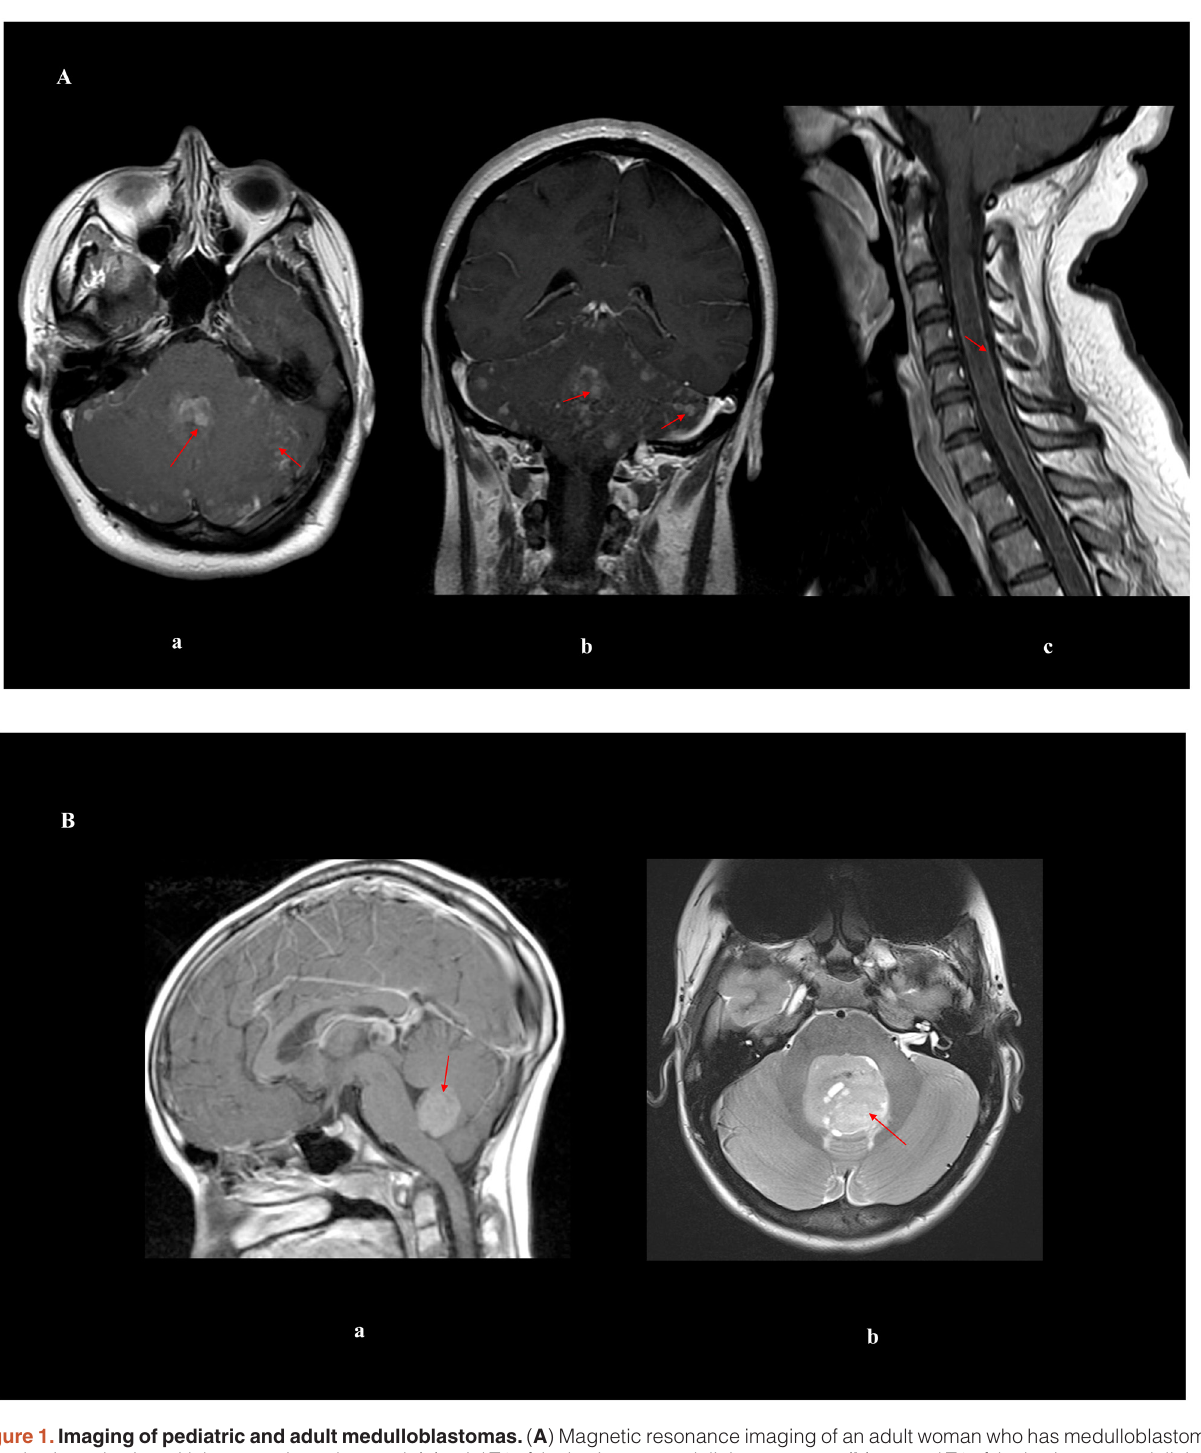
Figure 1. Imaging of pediatric and adult medulloblastomas. ( A ) Magnetic resonance imaging of an adult woman who has medulloblastoma in the brain and spine with leptomeningeal spread: ( a ) axial T1 of the brain post-gadolinium contrast; ( b ) coronal T1 of the brain post-gadolinium contrast; ( c ) sagittal T1 of the cervical spine post-gadolinium contrast. ( B ) Brain magnetic resonance imaging of pediatric medulloblastomas: ( a ) sagittal post-gadolinium WNT tumor; ( b ) axial T2 of a SHH tumor. Red arrows delineate the tumor/leptomeningeal